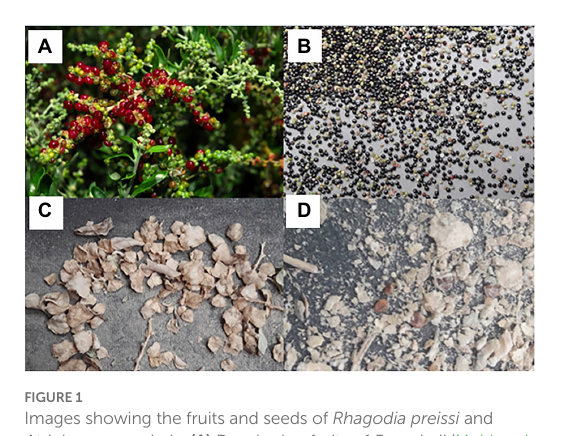
FIGURE 1 Images showing the fruits and seeds of Rhagodia preissi and Atriplex nummularia . (A) Developing fruits of R. preissii (Muirhead, 2017) that each contain one seed, (B) Seed of R. preissii both mature (black) and immature ones, (C) Fruits of A. nummularia with varying sizes of bracteoles, and (D) Cleaned seeds obtained by gently using corrugated rubber